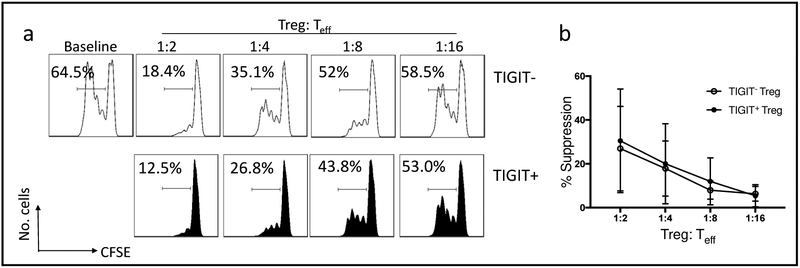
TIGIT-expression on Treg cells has no significant suppressive capacity. (a) Expanded human Treg subsets co-cultured with CFSE-labeled CD25− T cell and OKT3 (30ng/ml) for 72 hours in the presence of irradiated APCs. The CFSE dilution was examined by flow cytometry and data is representative of 4 independent experiments. (b) Statistical summary of 4 RA patients. There were no significant differences in suppressive capacity between TIGIT+ Treg and TIGIT− Treg subsets (p>0.05).